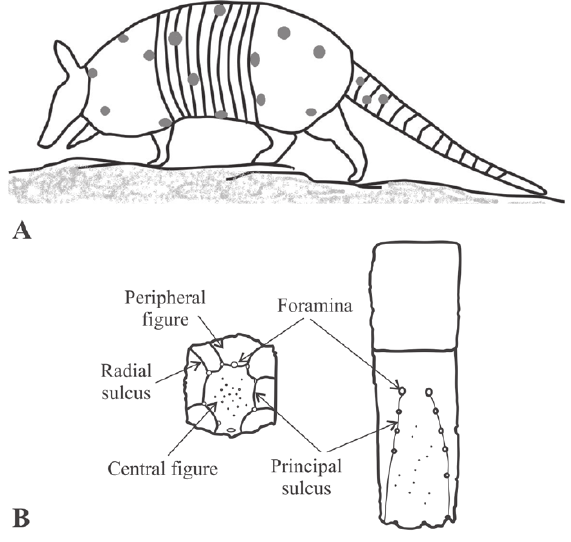
Figure 3 - A. Schematic drawing showing the position of the armadillo osteoderms; B. Terminology used for osteoderm morphology (dorsal view) in Dasypus . Fixed osteoderm (left) and moveable osteoderm (right). Modifi ed from Oliveira and Pereira